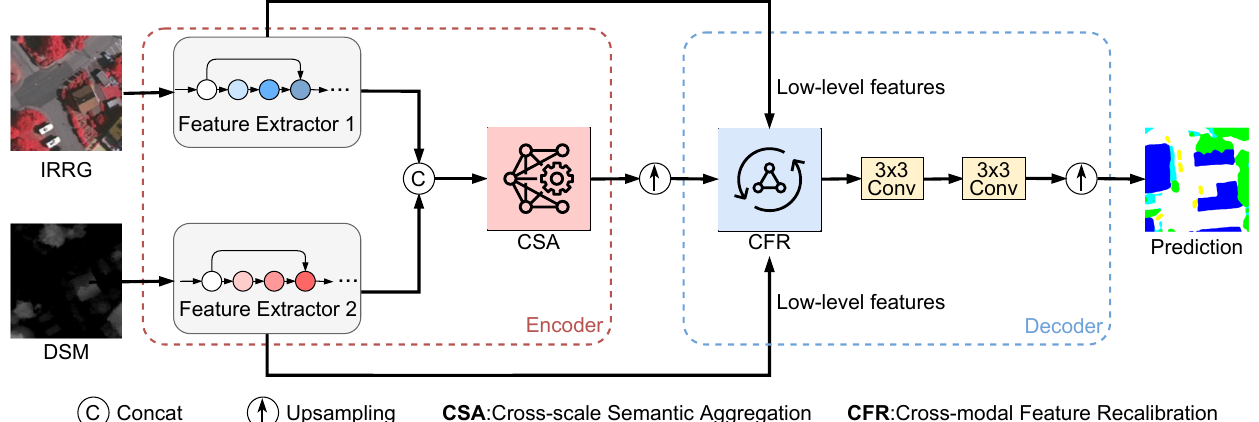
Figure 2. Framework overview of the proposed